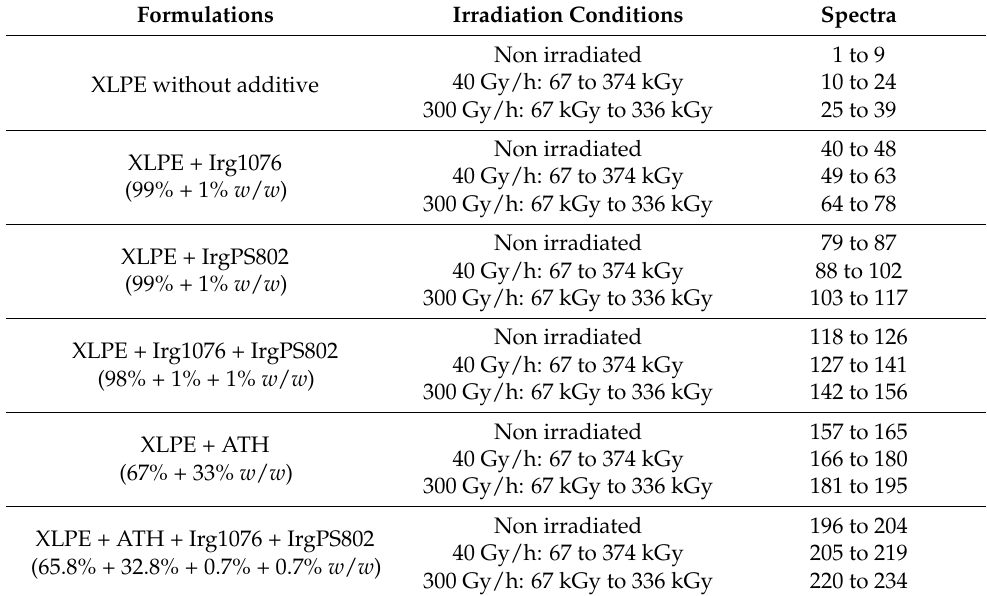
Table 3. Correspondence of formulations and spectra.